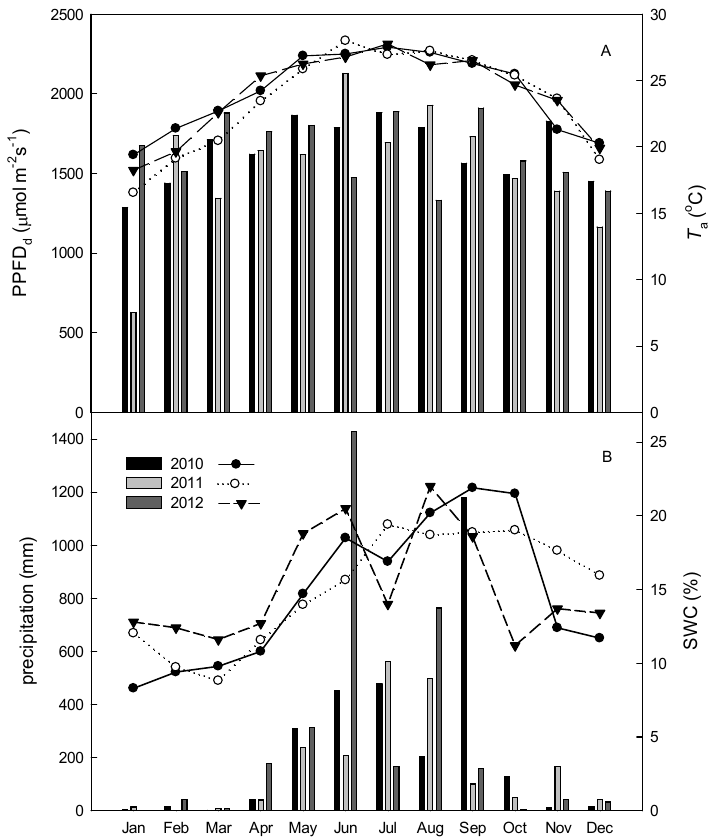
Figure 1. Monthly precipitation (bars), soil water content (SWC, lines), daytime light intensity (photosynthetic photon flux density (PPFD d ), bars), and air temperature ( T a , lines) from 2010 to 2012 at the Wan-Long Farm study site.